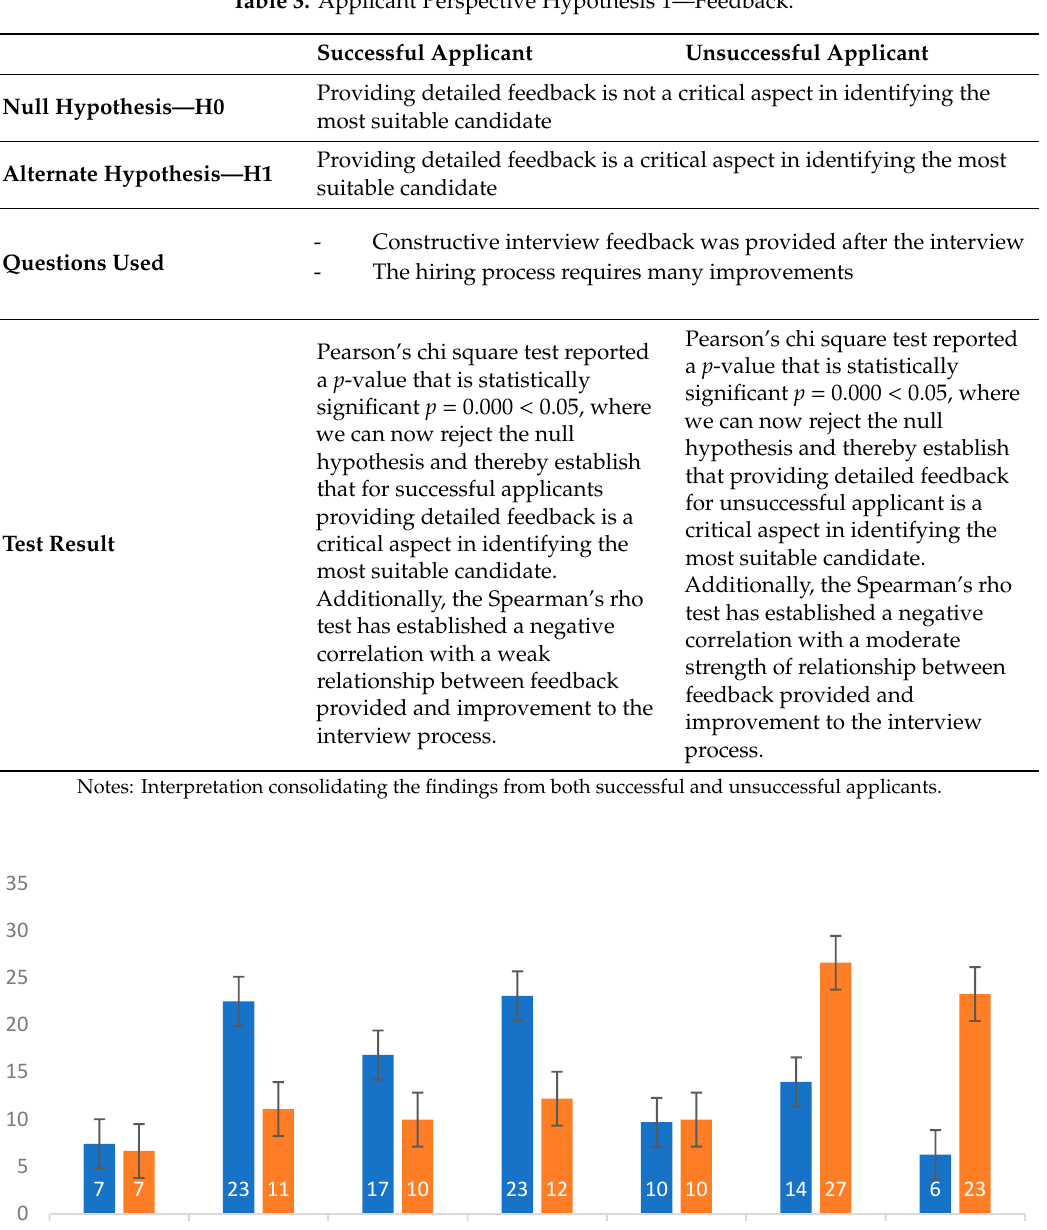
Table 3. Applicant Perspective Hypothesis 1—Feedback.